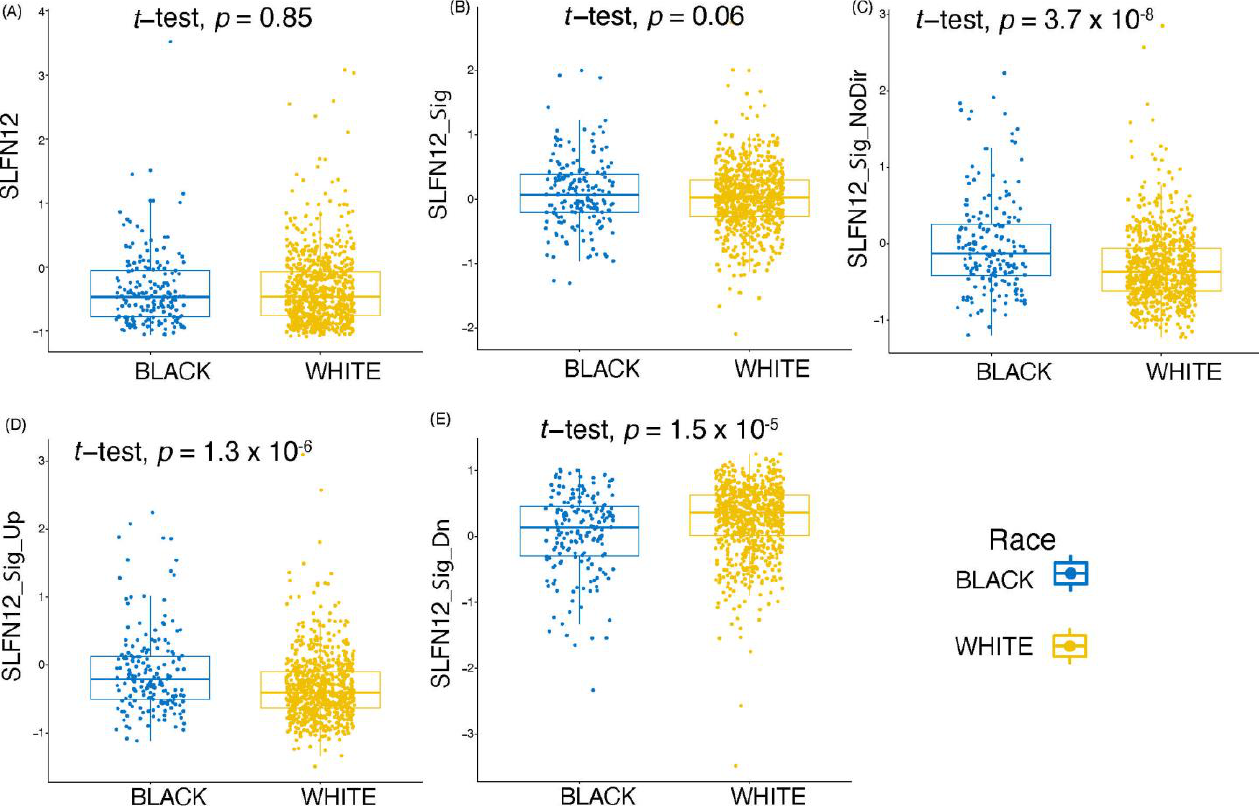
Figure 11. A box plot describing the race difference for ( A ) SLFN12, ( B ) SLFN12_Sig, ( C ) SLFN12_Sig_NoDir, ( D ) SLFN12_Sig_Up, and ( E ) SLFN12_Sig_Dn genes for white and black patients for